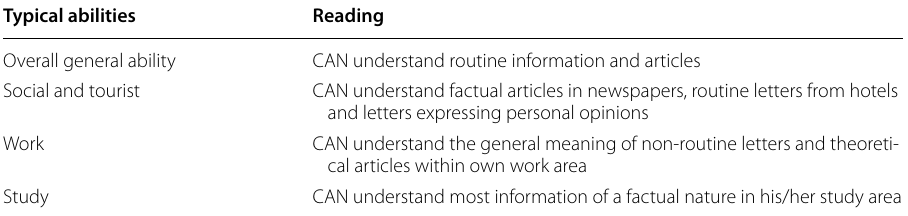
Table 2 Can do lists of B1 level reflected in B1 Preliminary reading paper (Cambridge English Qualifications, 2020, p.